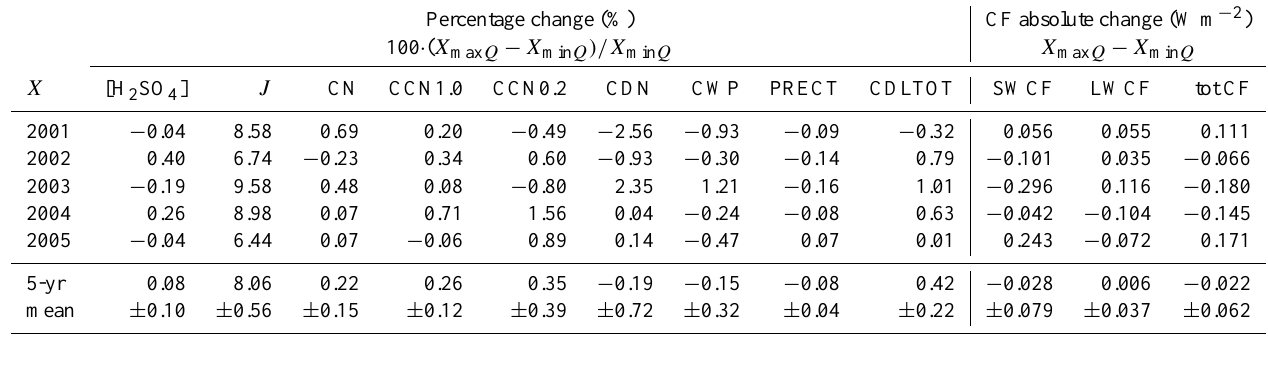
Table 2. The impacts of ionization rate ( Q ) changes from solar maximum (min Q ) to solar minimum (max Q ) on globally averaged particle and cloud properties as well as cloud forcing (CF). The uncertainty provided with each 5-yr mean value is the standard error based on 5-yr of simulation.